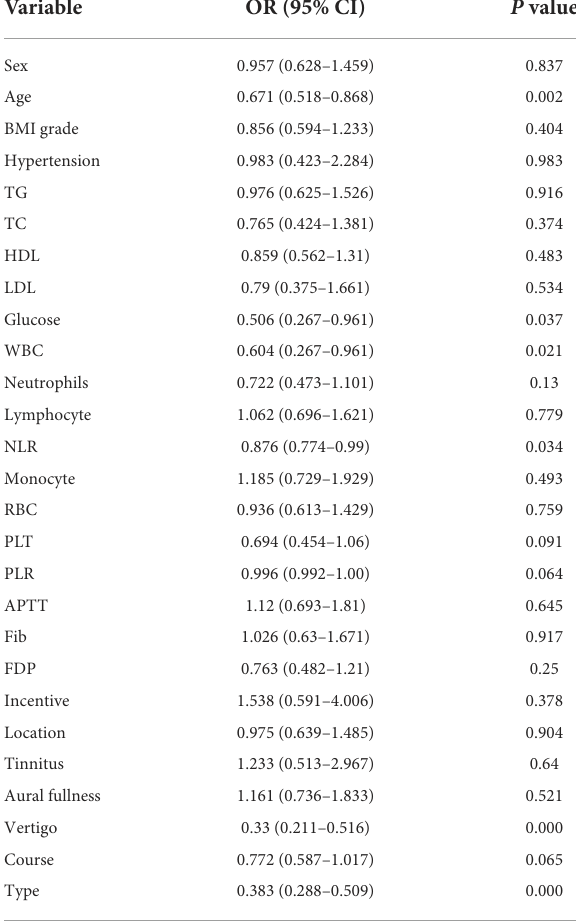
TABLE 2 Univariate logistic regression analysis of the treatment